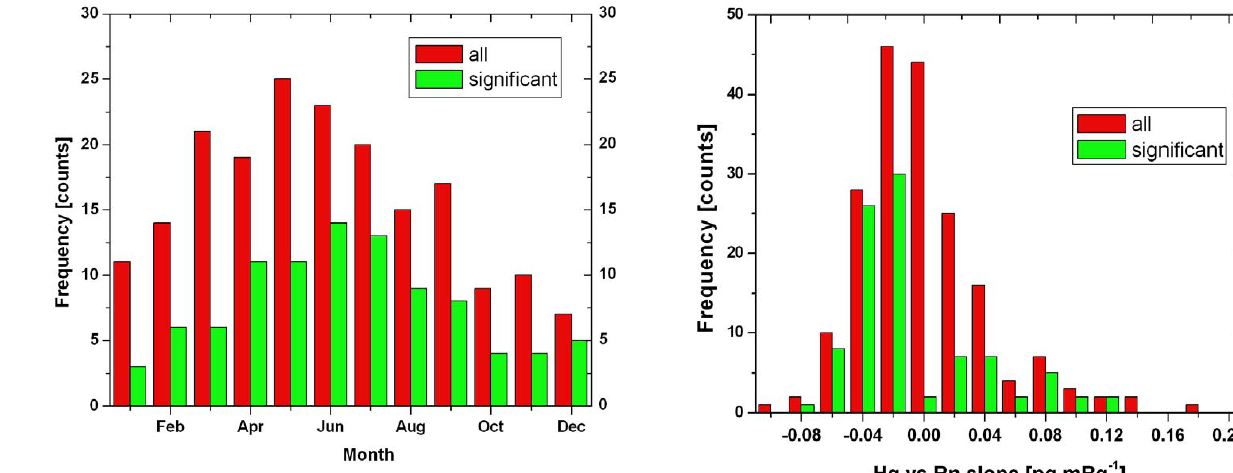
Fig. 2. Frequency distribution of all Hg/ 222 Rn slopes and only of Fig. 2: Frequency distribution of all Hg/ 222 Rn slopes and only of those which are those which are significant.